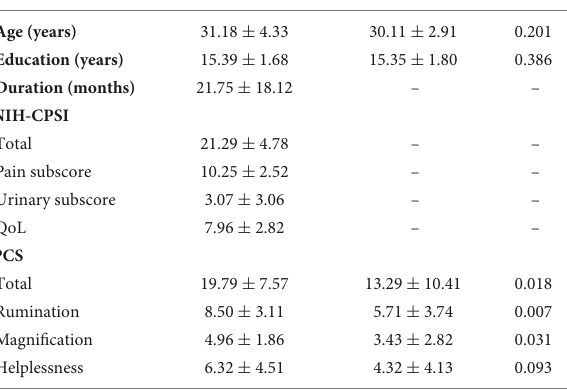
TABLE 2 Demographical, clinical data of CP/CPPS and healthy controls.